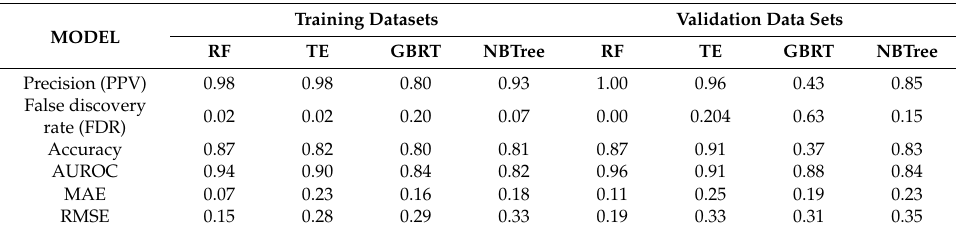
Table 6. Performances of RF, GBRT, NBT, and TE